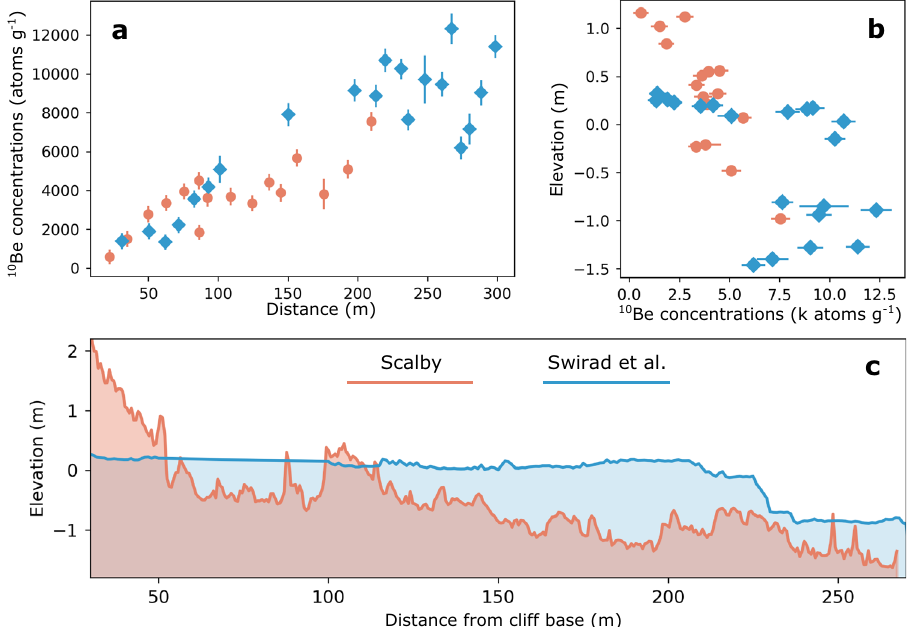
Fig. 6 | Comparisons between measured data at Scalby and Swirad et al. 21 study site. Measured concentrations of 10 Be (atoms g − 1 ) as a function of distance from cliff base(m)( a ).Measured 10 Beconcentrations(katomsg − 1 )asafunctionofelevation(m)atScalbyandSwiradetal. 21 studysite( b ).Across-shoretopographicpro fi le(m)( c